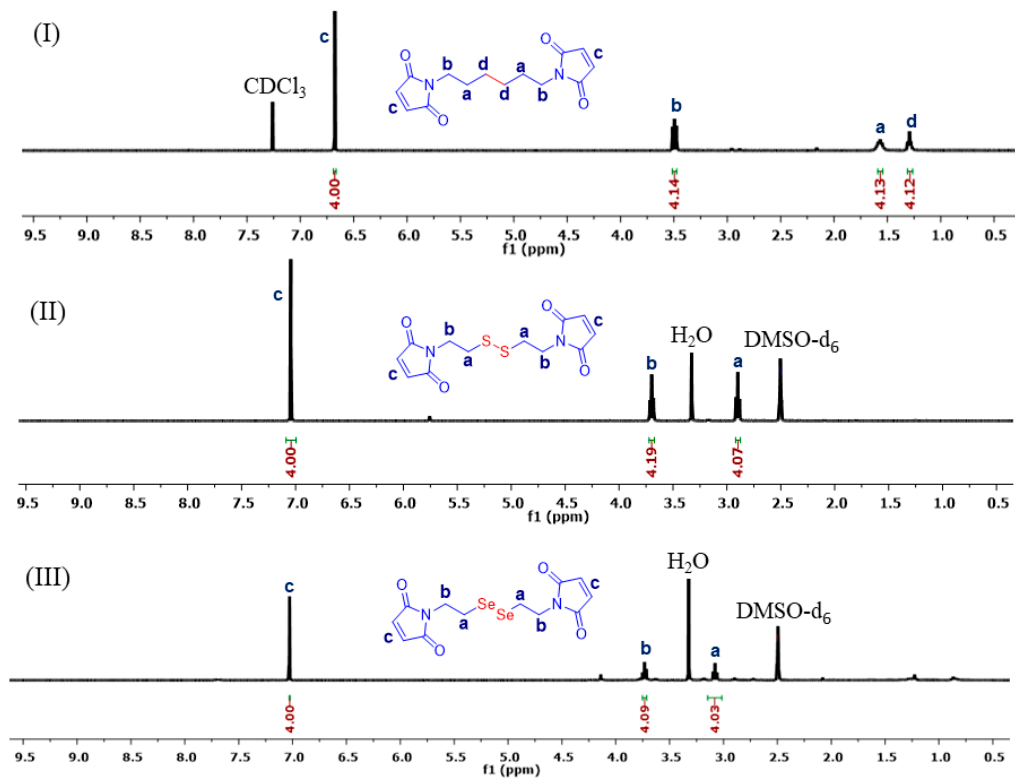
Figure 1. 1 H NMR of ( I ) BisMH in CDCl 3 , ( II ) DTME, and ( III ) DseME, cross-linker in DMSO-d 6